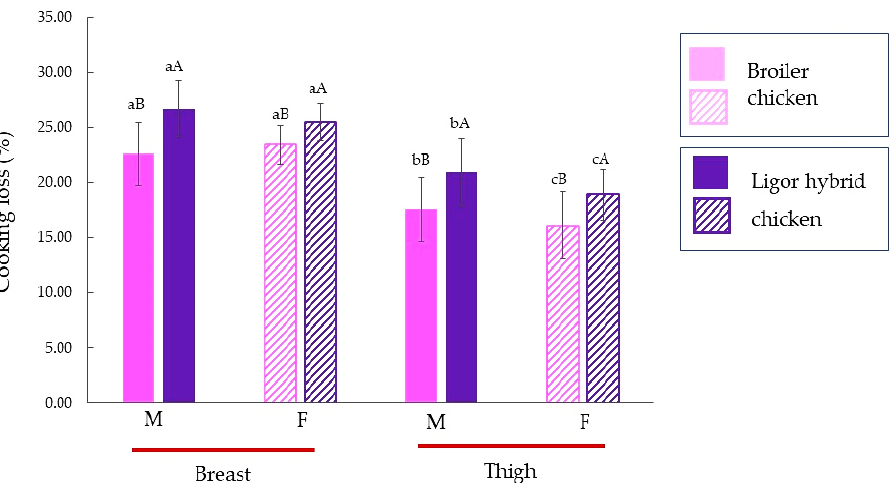
Figure 2. Cooking loss (%) of breast, thigh, and skin of broiler and Ligor hybrid chicken from different sex ( n = 15). Different lowercase superscripts (a–c) on the bar within the same genotype of chicken indicate significant differences ( p < 0.05). Different uppercase superscripts (A,B) on the bar under the same muscle type and sex of chicken indicate significant differences ( p < 0.05) by T -test. M, male chicken; F, female